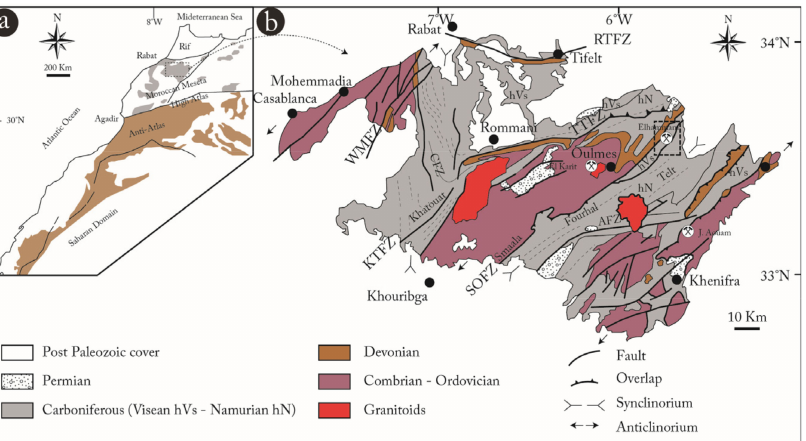
Figure 1. Structural domains of Morocco and location of the Central Morocco domain ( a ), and its main structural units [1,2] ( b ). (WMSZ: West Mestian Shear Zone, RTFZ: Rabat-Tiflet Fault Zone, SOFZ: Smaala-Oulmes Fault Zone, TTFZ: Tsili-Tfoudeit Fault Zone, AFZ: Aguelmous Fault Zone, KTFZ: Kef Tallal Fault Zone, CFZ: Cherrat Fault